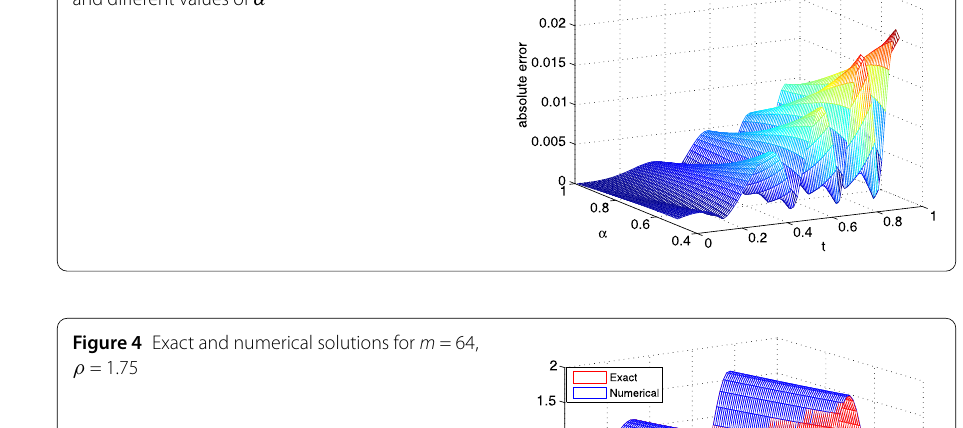
Figure 3 The absolute error for m = 64, ρ = 1.75, and different values of α